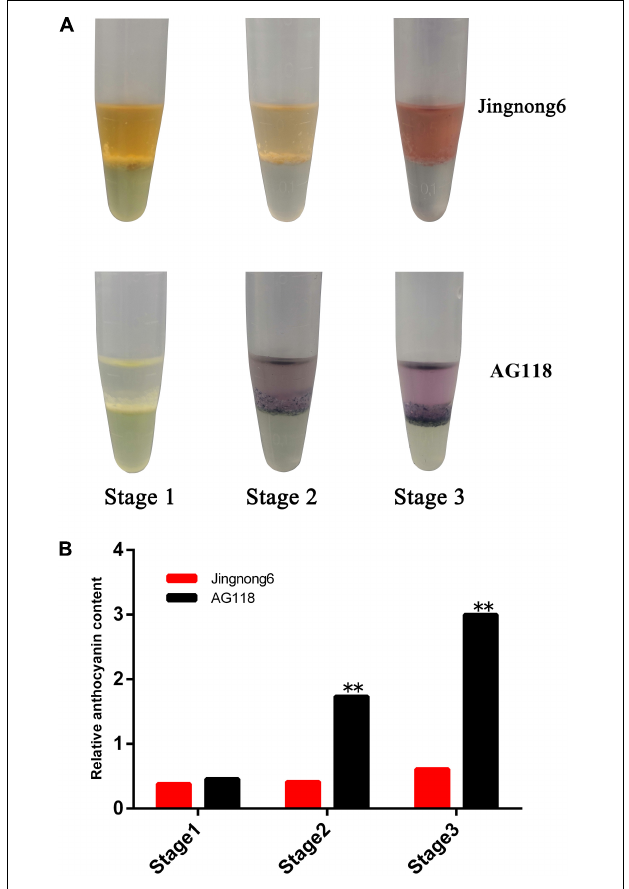
FIGURE 2 | Identification of colouring substance and content in seed coats of Jingnong6 and AG118. (A) Identification of colouring substances in the seed coats of different colouring stages; (B) relative anthocyanin content of Jingnong6 and AG118 seed coats in different colouring stages. ** P ≤ 0.01